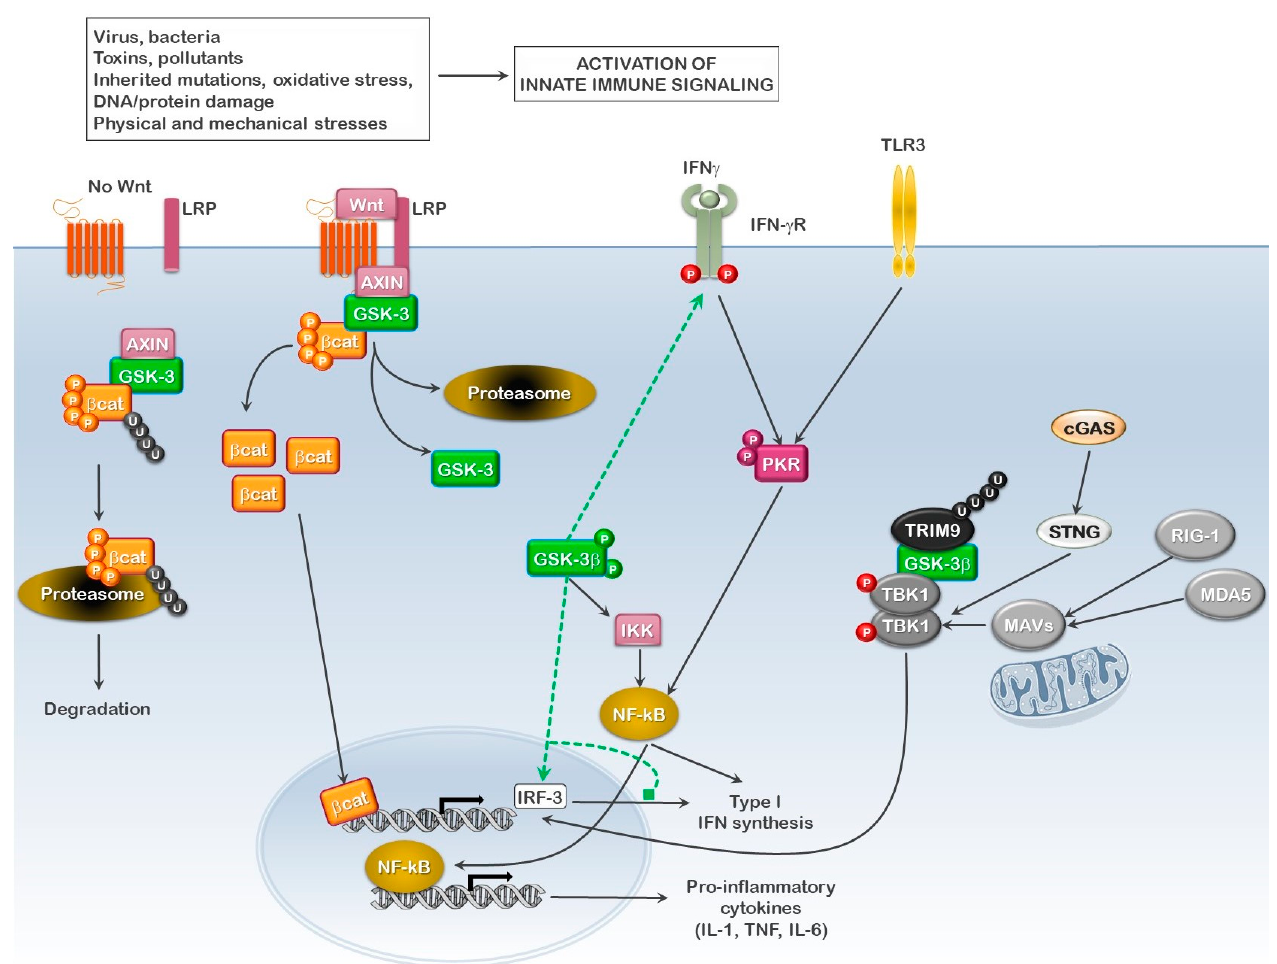
Figure 3. Role of GSK3 in regulating innate immune signaling. Synthesis of type I interferons requires both interferon response factor (IRF), NF- κ B activation and nuclear localization, and the subsequent binding to their respective elements in the IFN α / β promoter. In the presence of active GSK3, β -catenin is phosphorylated and degraded, thus inhibiting the synthesis of IRF-3, while NF- κ B activation and nuclear localization are stimulated, thus favoring the synthesis of pro-inflammatory cytokines. In addition, active GSK3 also stabilizes the IFN γ receptor (IFN γ R), thus enhancing IFN γ pro-inflammatory signaling. In the absence of GSK3 activity, β -catenin is released upon stimulation, translocates to the nucleus and promotes the synthesis of IRF-3. Signaling mediated by the pattern recognition receptor (PRR) proteins (RIG-I, MDA5, cGAS) promotes IRF-3 activation and nuclear localization, while the activation of PKR results in p65 NF- κ B phosphorylation, activation and nuclear translocation where active p65 NF- κ B either synergizes with signaling mediated by the other PRRs to aid in the synthesis of type I IFN (GSK3 inactive) or induces the synthesis of pro-inflammatory cytokines (GSK3 active).